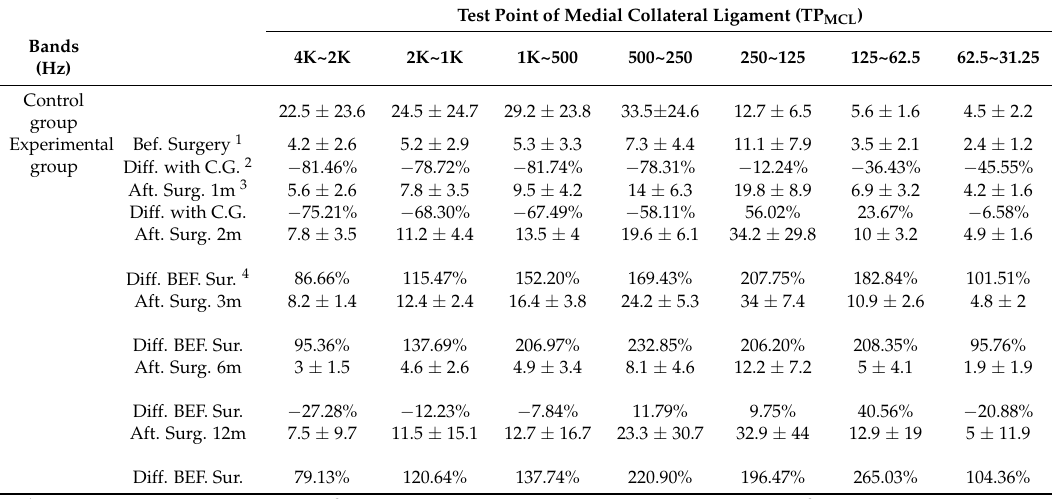
Table 1. Object average data of medial collateral ligament between the control and experimental groups. Test Point of Medial Collateral Ligament (TP MCL )